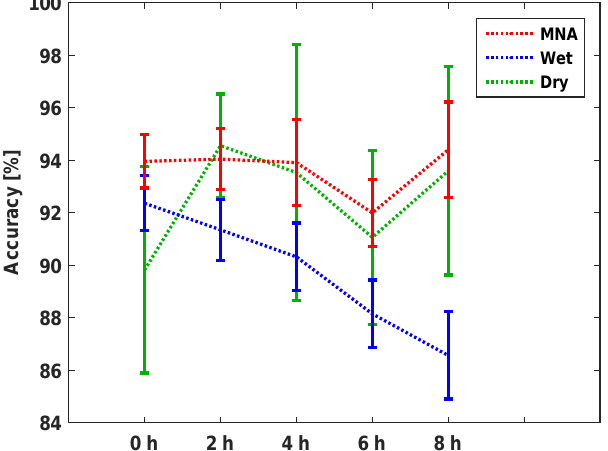
Figure 17. Temporal changes of the LDA classification